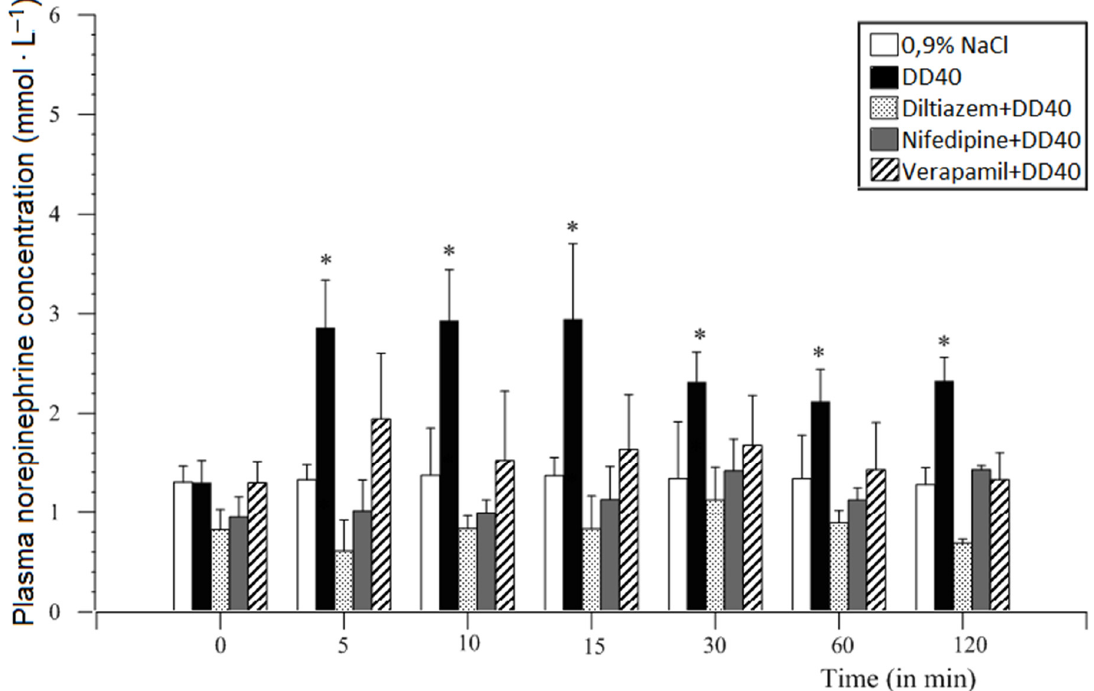
Figure 12. Comparative analysis of duodenal distension and premedication with different doses of diltiazem, nifedipine, and verapamil (1.0 or 2.0 mg/animal) on plasma norepinephrine concentration in comparison with DD40 (mean ± SEM, n = 6, p ≤ 0.001–0.05). Mean values of results obtained from the same blood collection (time point). Significant differences are marked with asterisks [34,50].